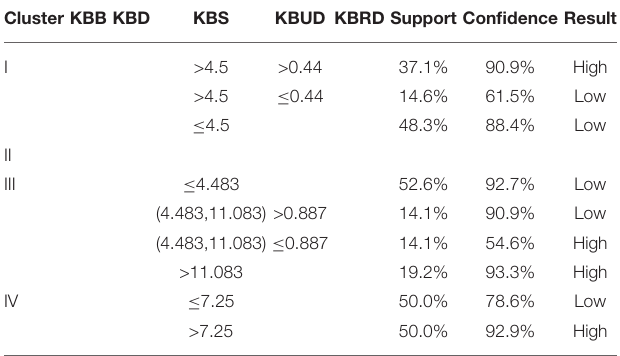
TABLE 3 | Decision rules of exploitative innovation performance (EIP2).